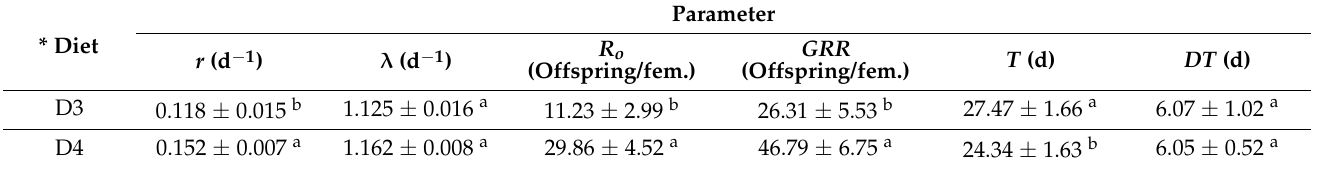
Table 3. Mean ± SE of the estimated life table parameters of S. gilvifrons fed on two different diets containing A. franciscana cysts.